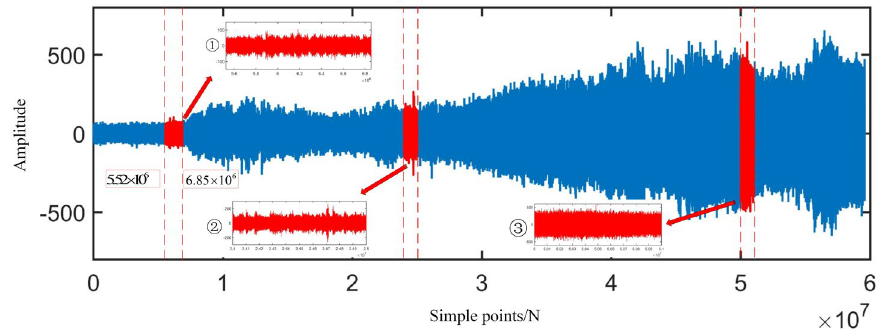
Figure 8. Time domain diagram of the original signal.